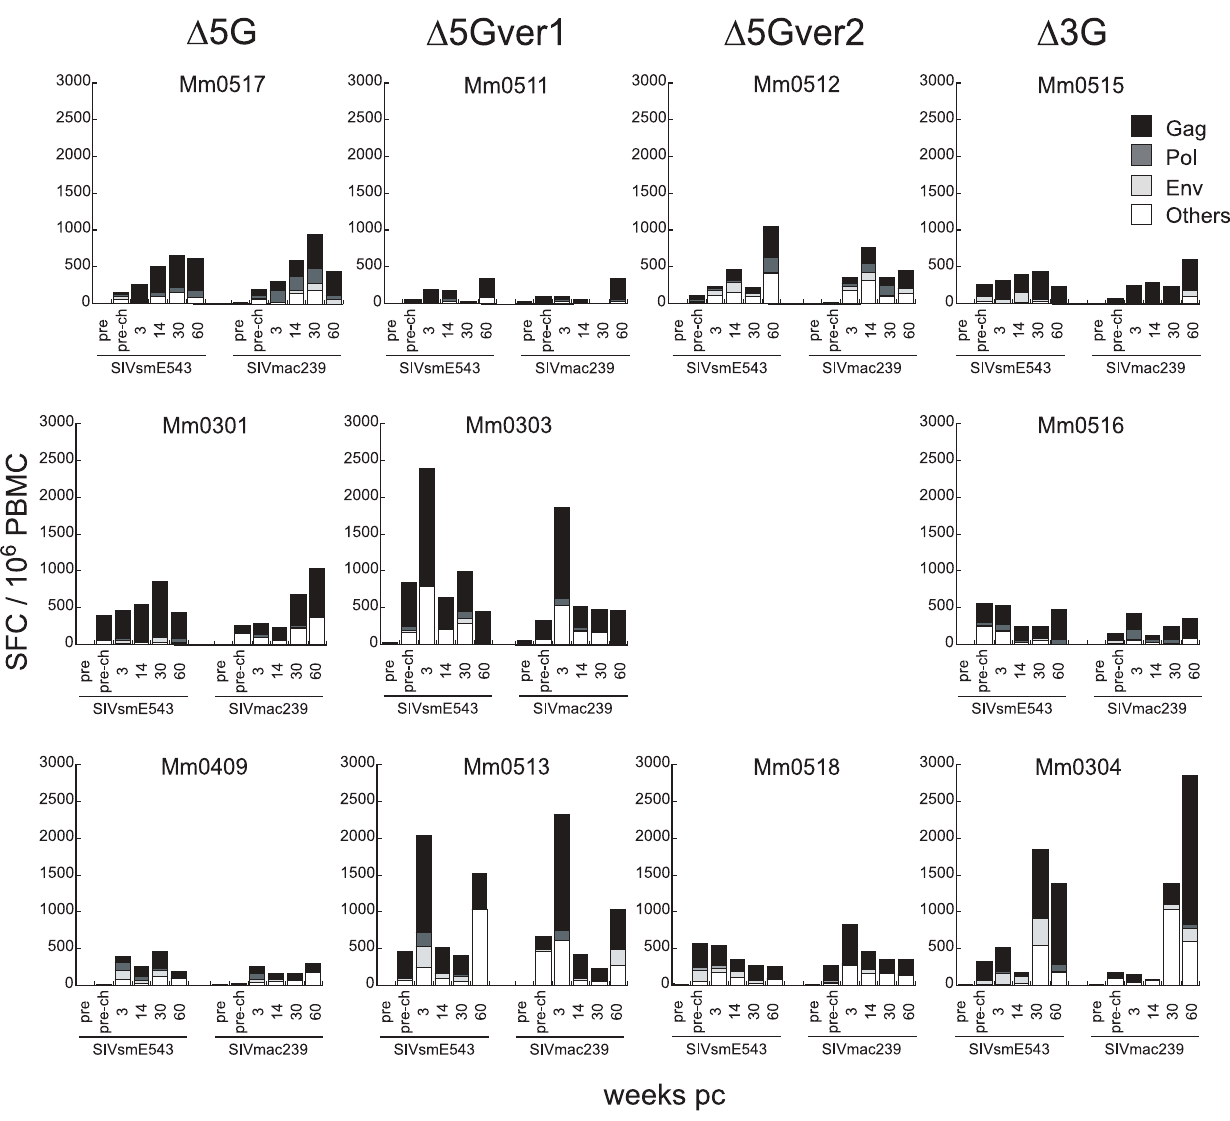
Figure 6. SIV specific cellular response in the vaccine recipients. SIV specific T cells were stimulated with overlapping peptides encompassing the viral proteins (Gag, Pol, Env, and Others: Vif, Vpr, Vpx, Tat, Rev, and Nef) of SIVmac239 and SIVsmE543-3 and the number of spot forming cells (SFC) per 10 6 PBMC determined utilizing the IFN- c ELISPOT assay. The PBMC samples analyzed for the responses included those collected pre- vaccination, pre-challenge (4–8 weeks prior to the challenge) and at 3, 14, 30 and 60 weeks